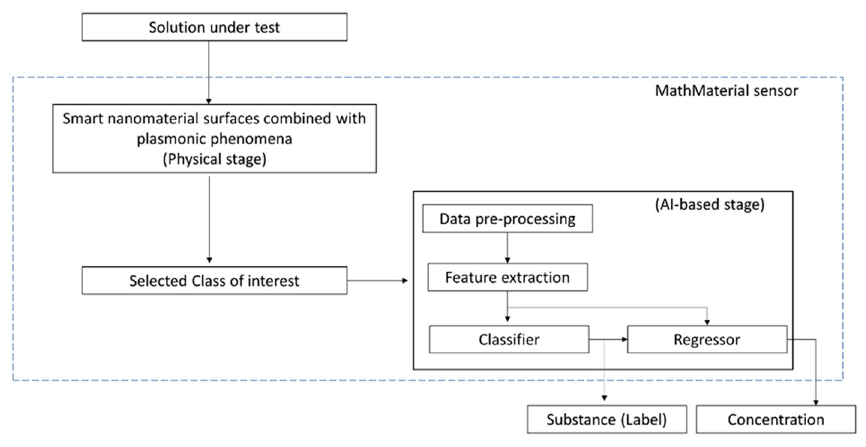
Figure 6. Outline of the MathMaterial sensing approach.